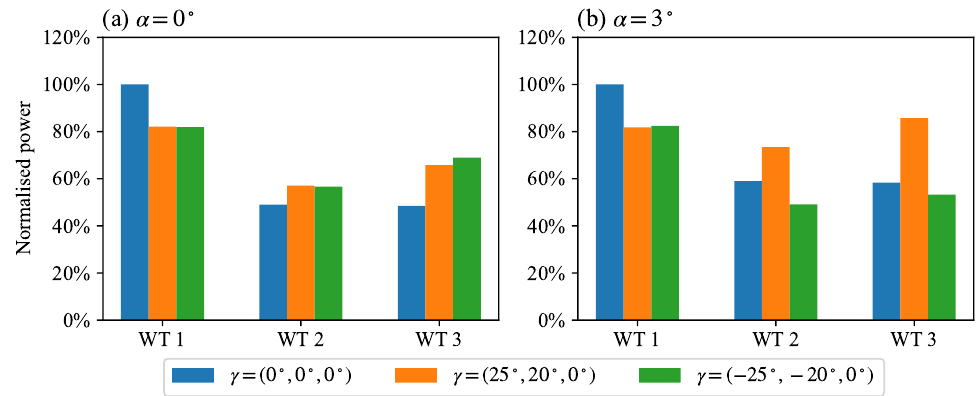
Figure 6. Normalised power outputs of different AYC configurations, normalised by the power of WT 1 in zero yaw ( a ) in full-wake configuration α = 0 ◦ and ( b ) in partial-wake configuration α = 3 ◦ .